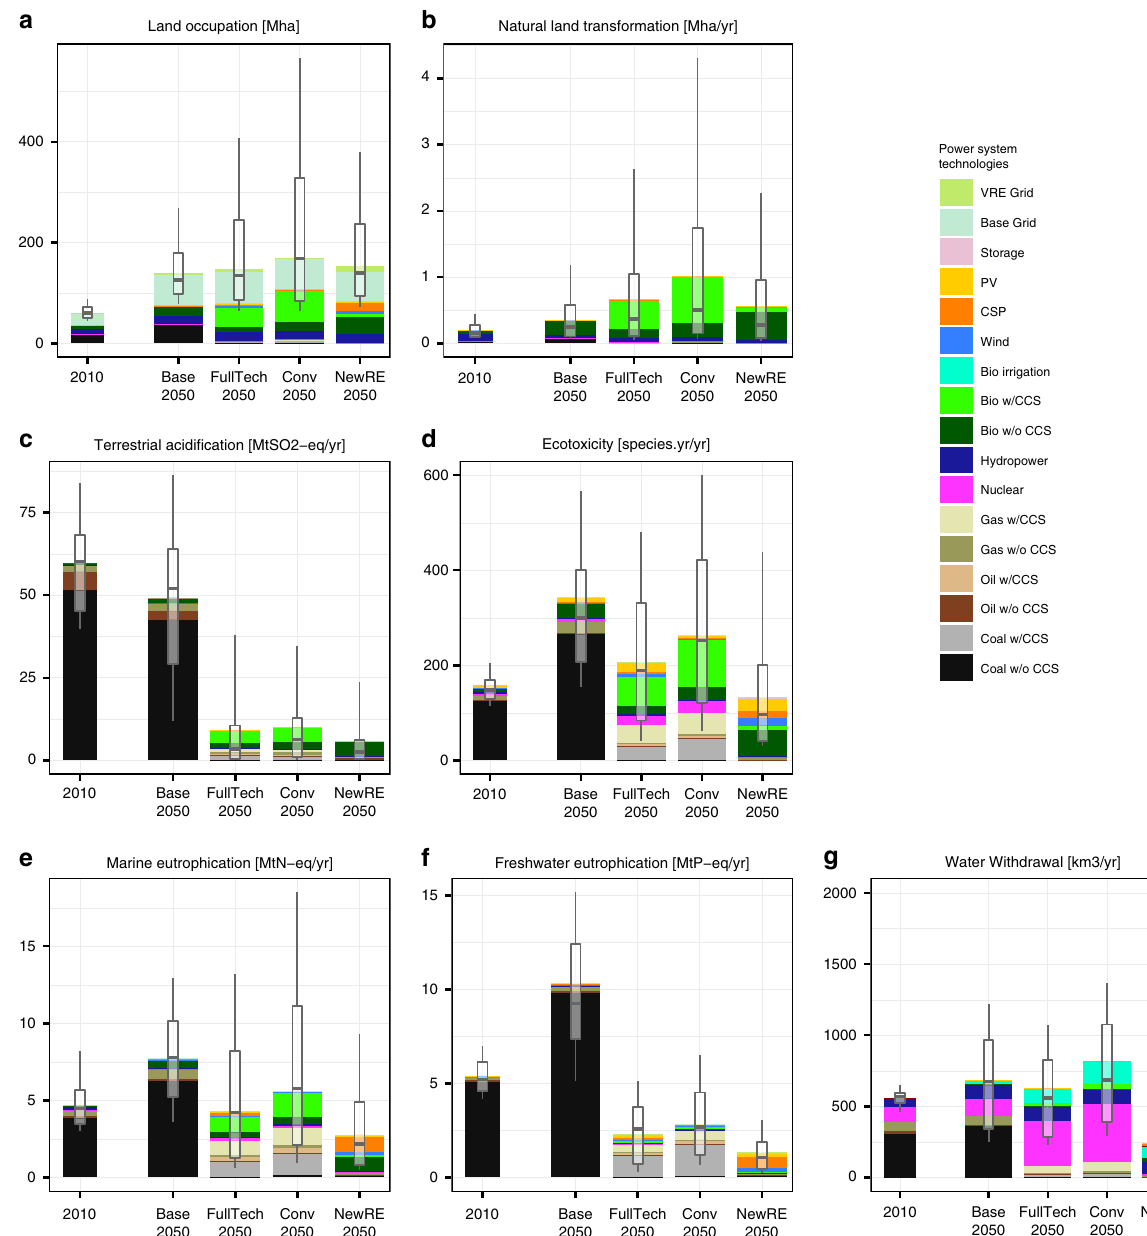
Fig. 4 Environmental impacts affecting ecosystems. Globally aggregate environmental impacts from a land occupation, b natural land transformation, c terrestrial acidi fi cation, d freshwater ecotoxicity, as well as e marine and f freshwater eutrophication, as well as g water withdrawal, for 2010 and 2050 under different power sector transformation scenarios. Ecotoxicity was calculated as the aggregate of terrestrial, marine and freshwater ecotoxicity in units of species-years using characterization factors from ref. 23 . Stacked bars indicate mean across all combinations for LCA studies and IAM scenario realizations. Boxplots indicate median and interquartile ranges across technology variants and participating integrated assessment models, whiskers 10th − 90th percentile ranges. Ranges do not re fl ect uncertainty in environmental impact